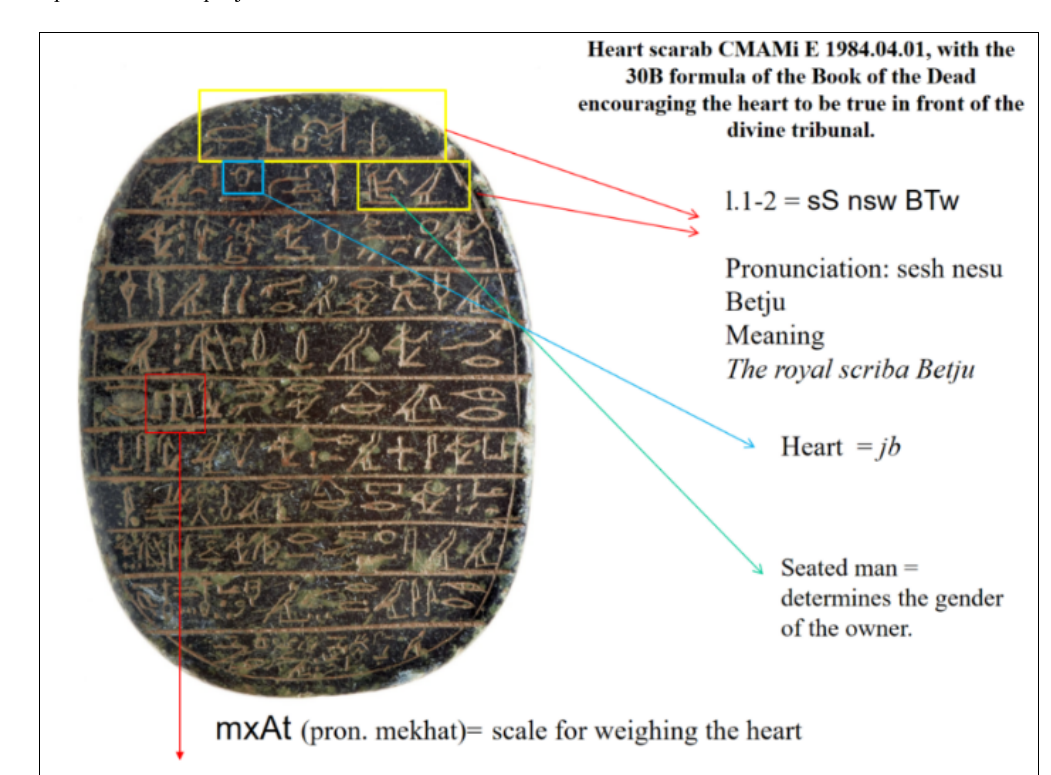
Figure 5. Example of contents that can be highlighted thanks to the 3D digital application: words on Scarab of the Heart, usually placed on the chest of the deceased as an